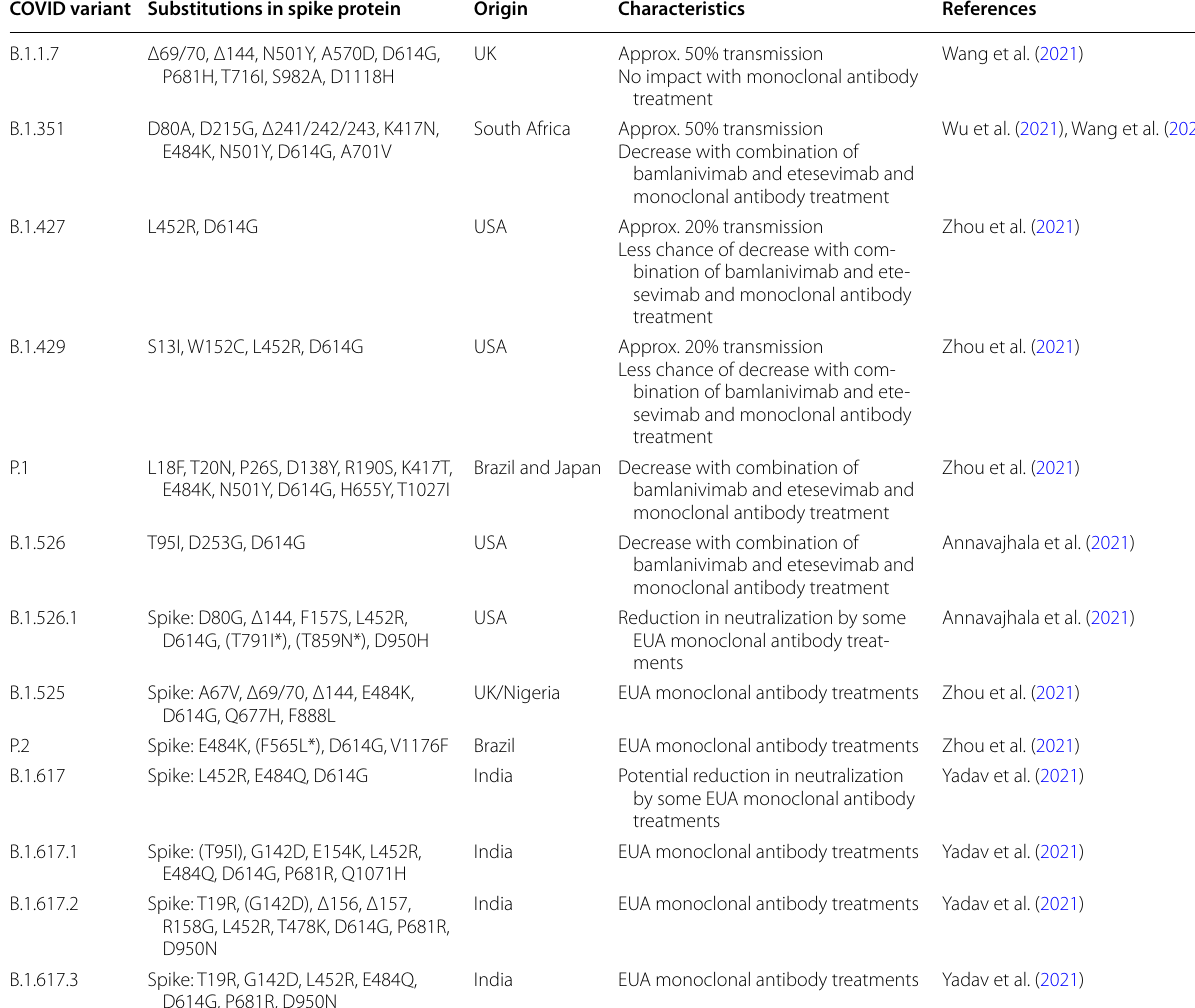
Table 1 A list of different SARS-CoV-2 variants that occurred globally COVID variant Substitutions in spike